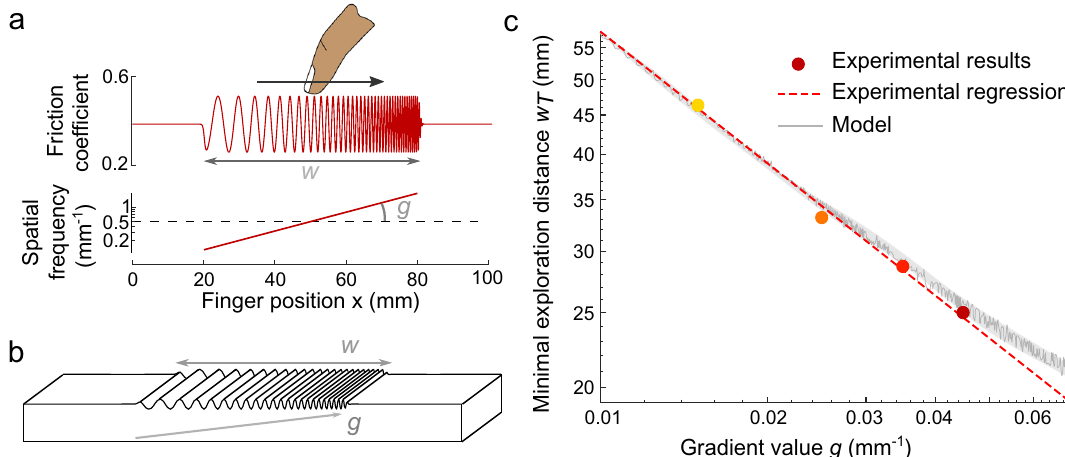
Figure 1. Overview of the experiment on haptic gradient detection thresholds. Subjects explore a synthetic sinusoidal grating whose spatial frequency evolves exponentially with respect to the finger position. a. 1 Illustration of the haptic stimulus for the gradient value condition g = 0.045 mm − and the window size w = 60 mm. This stimulus is the one with the widest spatial frequency range, from ν = 0.13 to 1.93 mm − 1 with 1 a central frequency ν 0 = 0.5 mm − . Explored with a finger velocity of approximately v = 60 mm/s, it produces vibration of frequency f = ν ∗ v from 8 to 116 Hz, centered on 30 Hz. Stimuli at the thresholds stay within 17 to 52 Hz. b. Illustration of the illusion produced by modulating fingertip friction with the haptic interface. c. Minimal exploration distances w T necessary to detect the variation in ridge density, shown as dots for various 2 = 0.997 gradient values g . Logarithmic regression, shown by the dashed red line, leads to a goodness of fit R . The model predictions are shown in dark gray, and the margin of error is shown in light